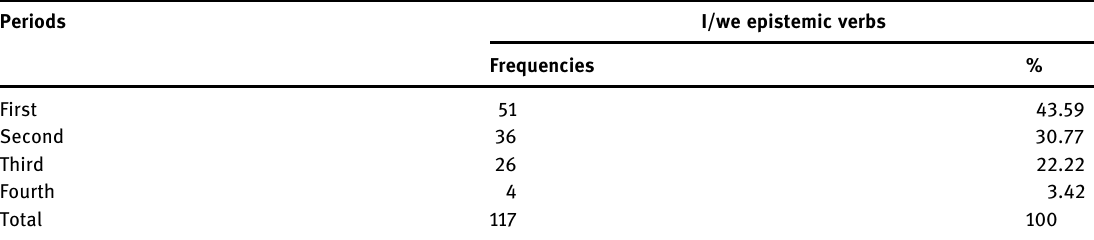
Table 9: Frequencies and percentages of I/we epistemic verbs in the four time periods